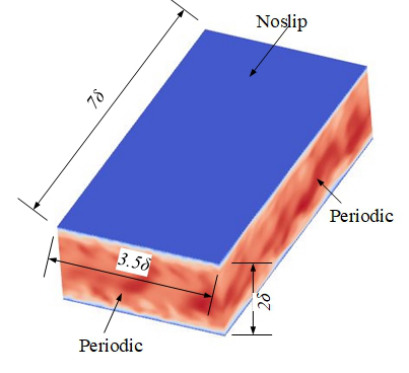
Figure 2. Diagram of flow domain size and boundary